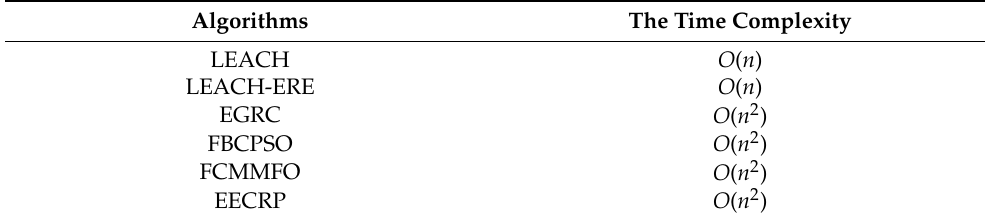
Table 2. The time complexity of six algorithms.